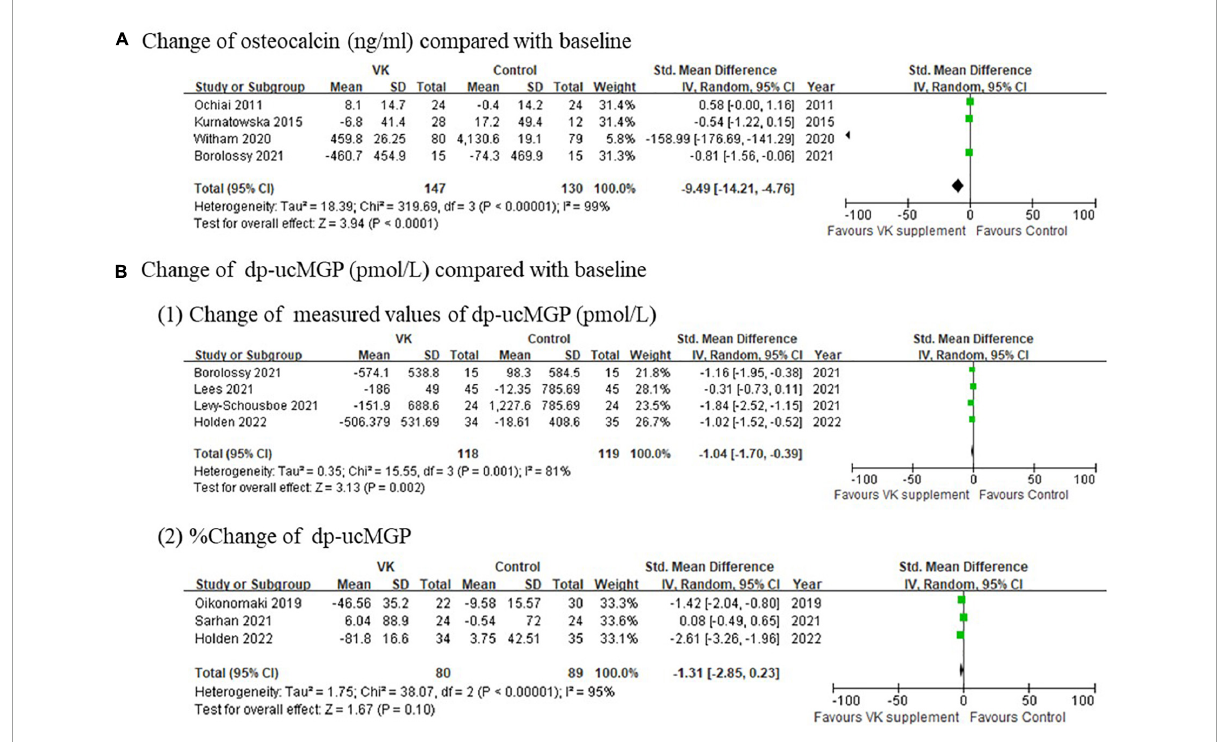
FIGURE2 Pooled changes of (A) osteocalcin and (B) dp-ucMGP after Vitamin K supplementation compared with